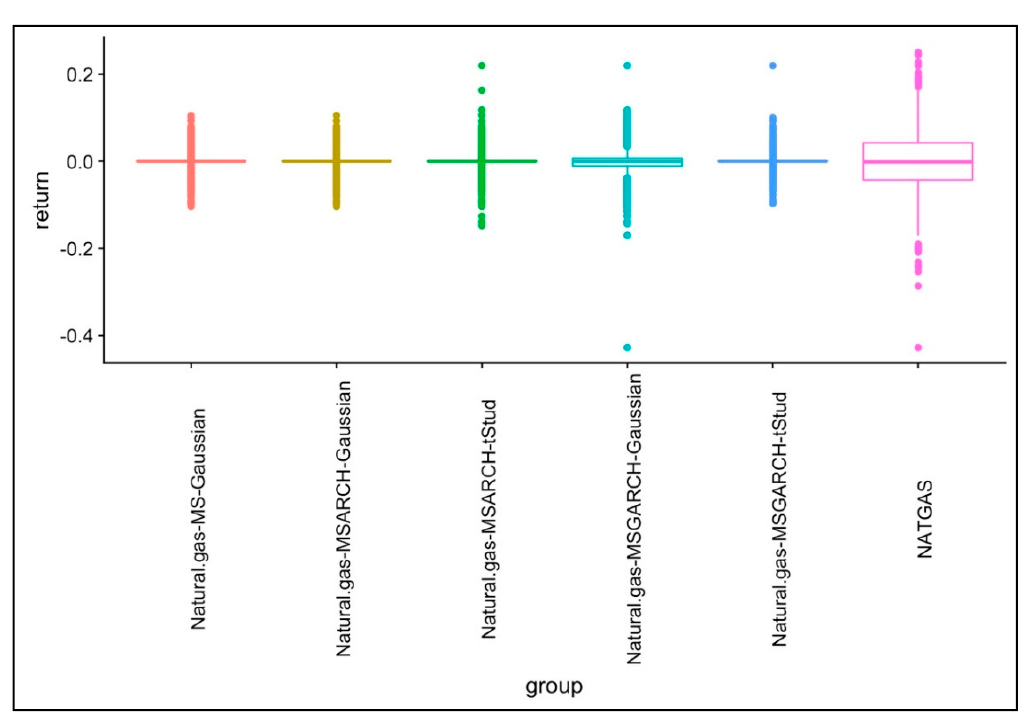
Table 10. Attribution and market timing test of the five simulated portfolios in the NATGAS market.